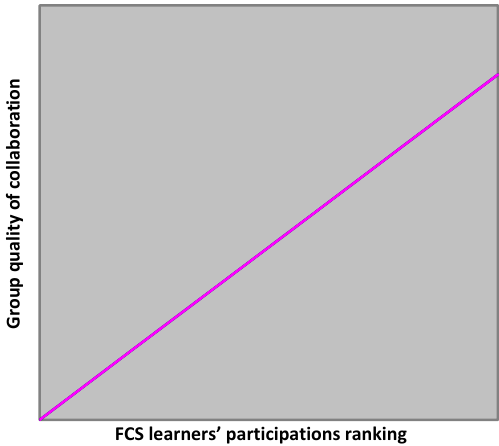
Figure 27. Group quality of collaboration assessment.